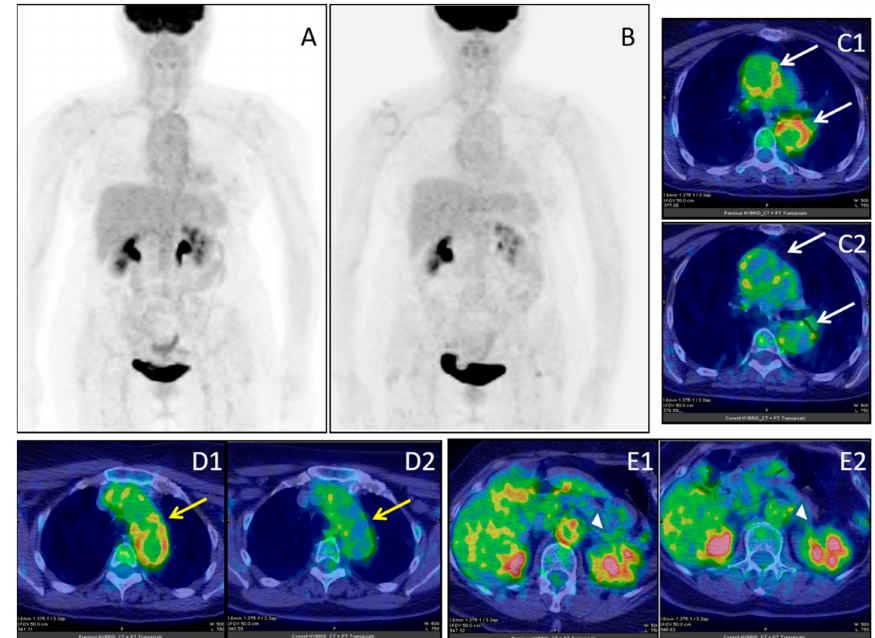
Figure 5. Female, 64 years-old; ( 18 F)-FDG-PET / CT MIP in giant cell arteritis (GCA) before ( A ) and after ( B ) immuno-suppressive treatment; ascending and descending aorta (white arrows), before ( C1 ) and after ( C2 ) treatment; aortic arc (yellow arrow), before ( D1 ) and after ( D2 ) treatment; abdominal aorta (white arrow-head), before ( E1 ) and after ( E2 )